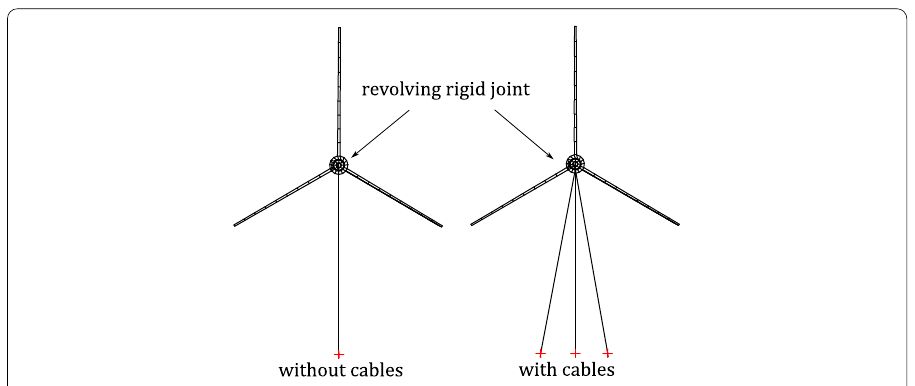
Fig. 12 Cables effect on the bending of the tower: geometry of structure